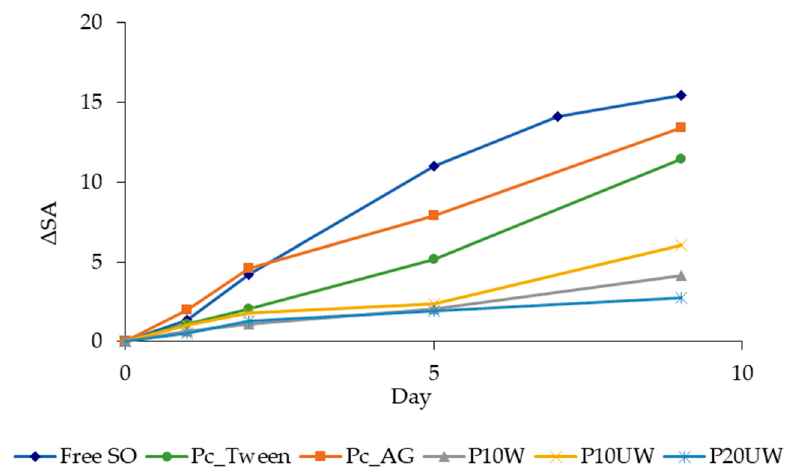
Figure 3. CD (expressed as Δ SA =SA(t) − SA(0) value) of Free SO and of spray dried emulsions, determined at different storage times up to 9 days. Sample codes are explained in Table 1.